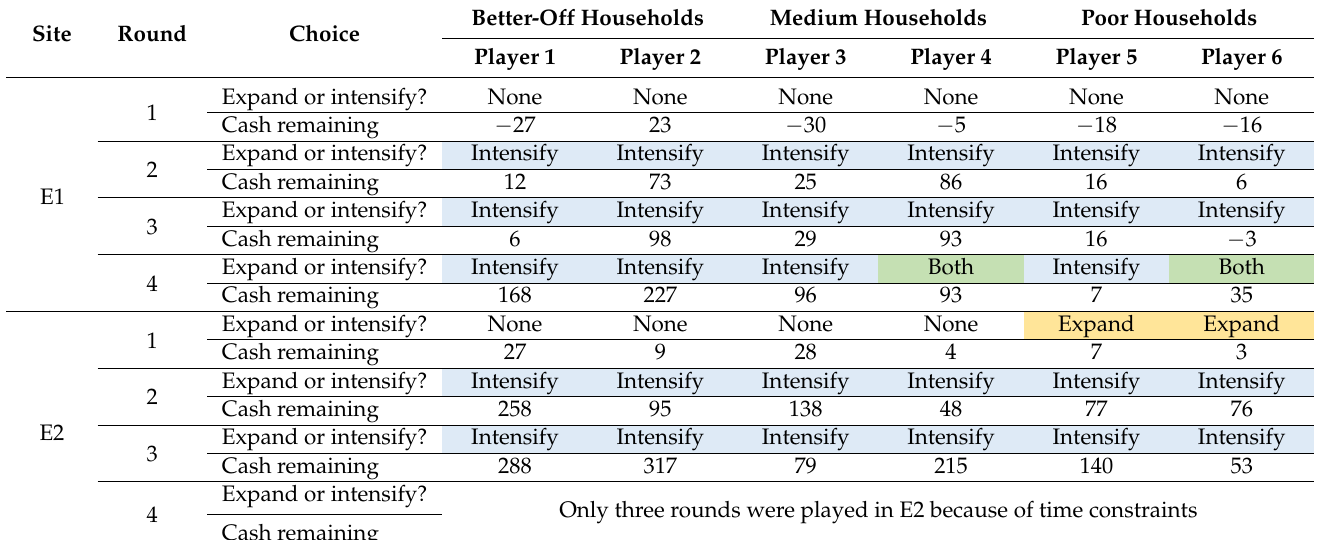
Table 3. Game outcomes (choices per round for all